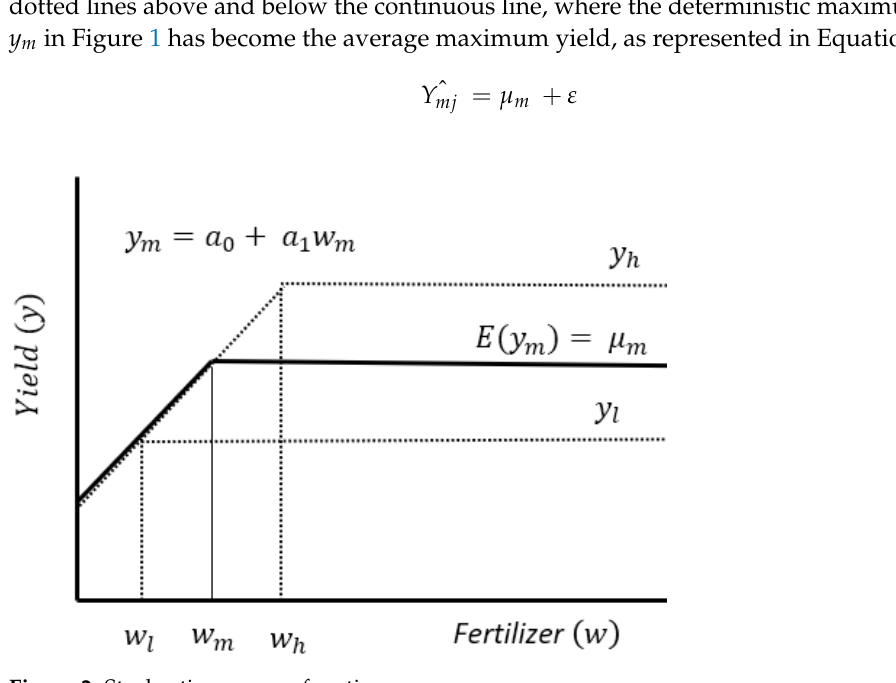
Figure 2. Stochastic response function.